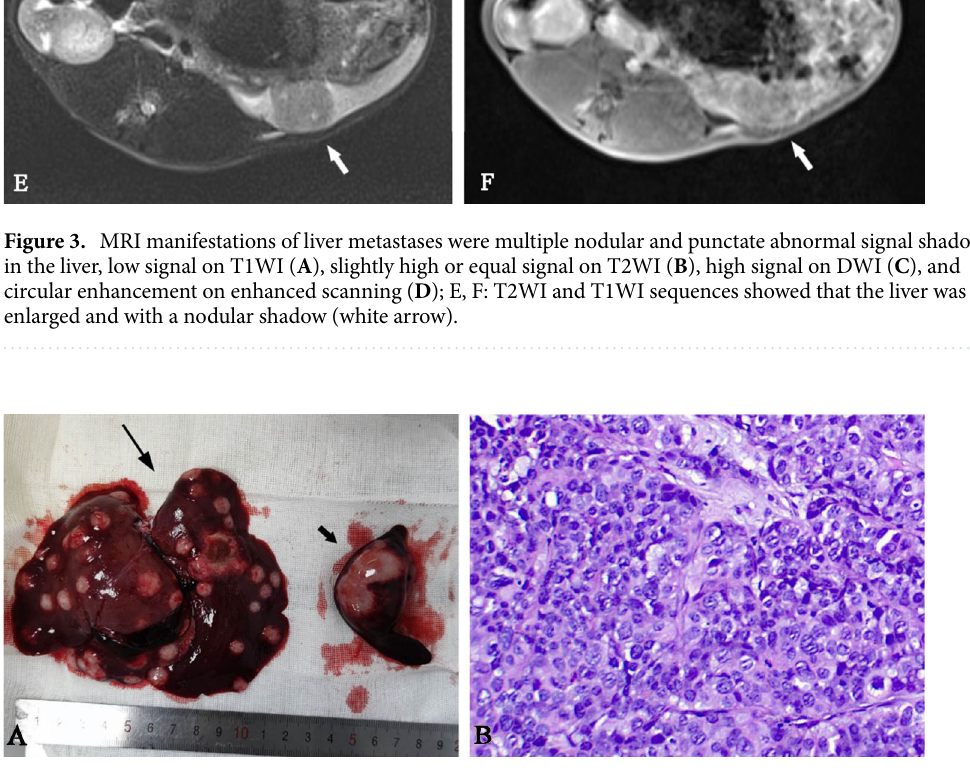
Figure 4. The specimens ( A ) showed multiple gray-white nodular shadows in the liver (long black arrow); The volume of the spleen (short black arrow) was increased, and a fish-like nodular tumor could be seen; ( B ) HE staining showed that the nucleus was large and deeply stained, and the morphology was